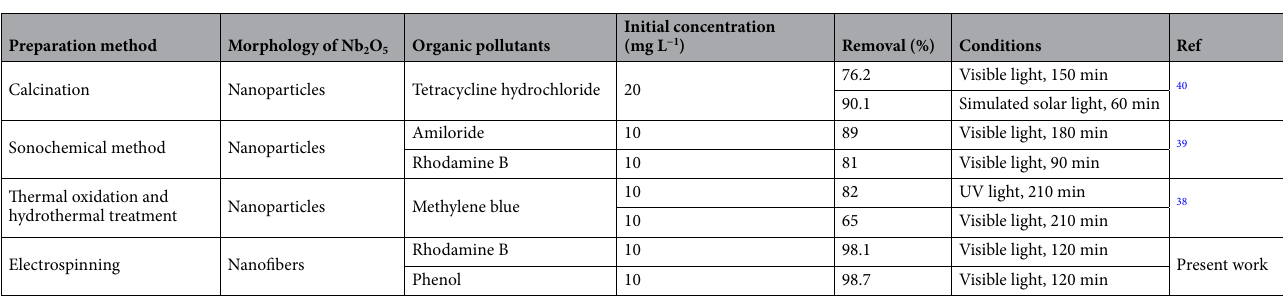
Table 1. Summary of the photocatalytic activity on various g-C 3 N 4 /Nb 2 O 5 composites.